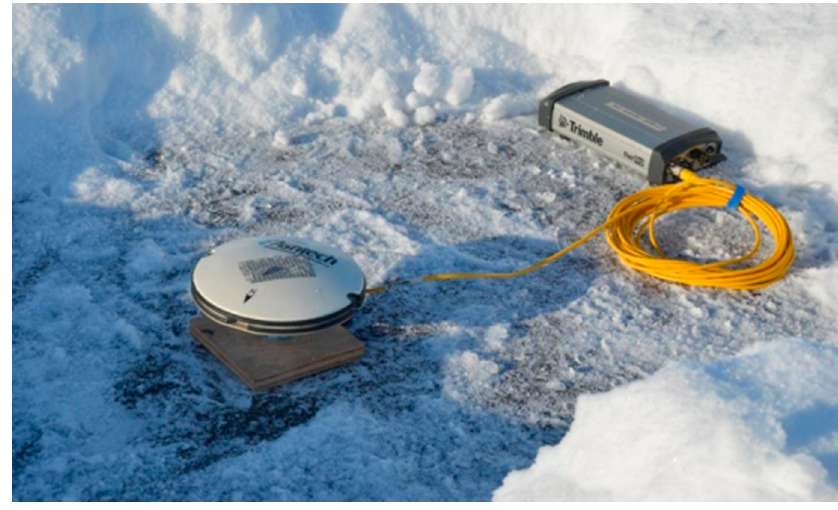
Figure 4. GNSS antenna and receiver setup on the lake ice surface.